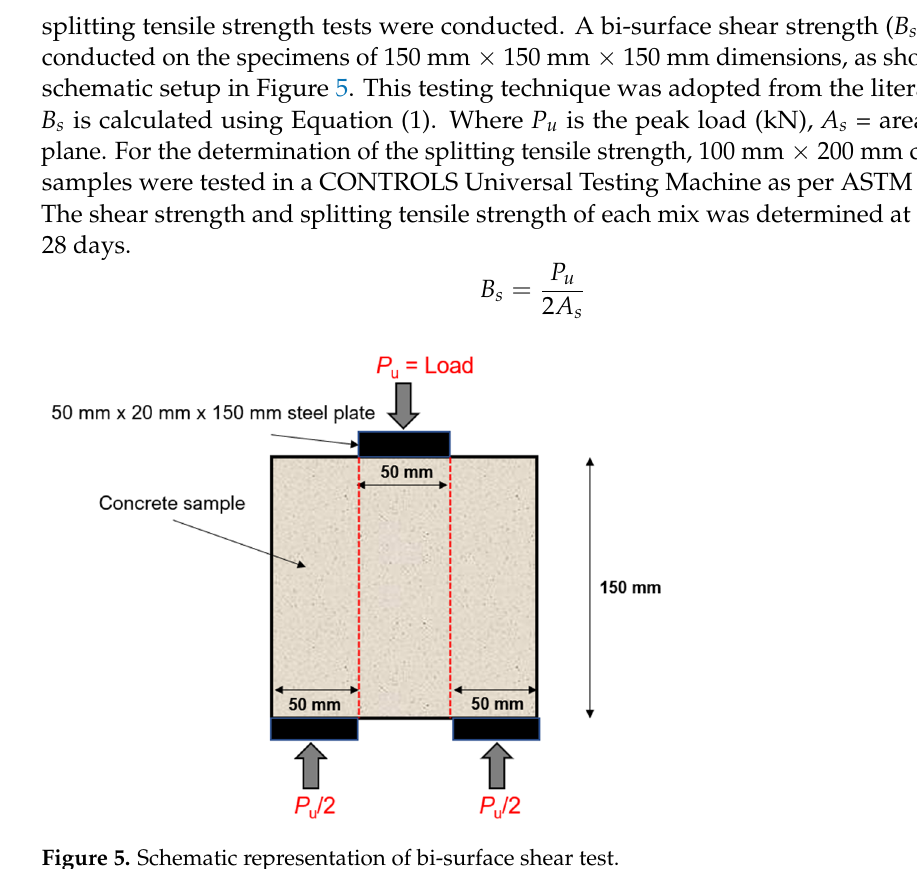
Figure 6. Chloride ion penetration in the concrete sample.